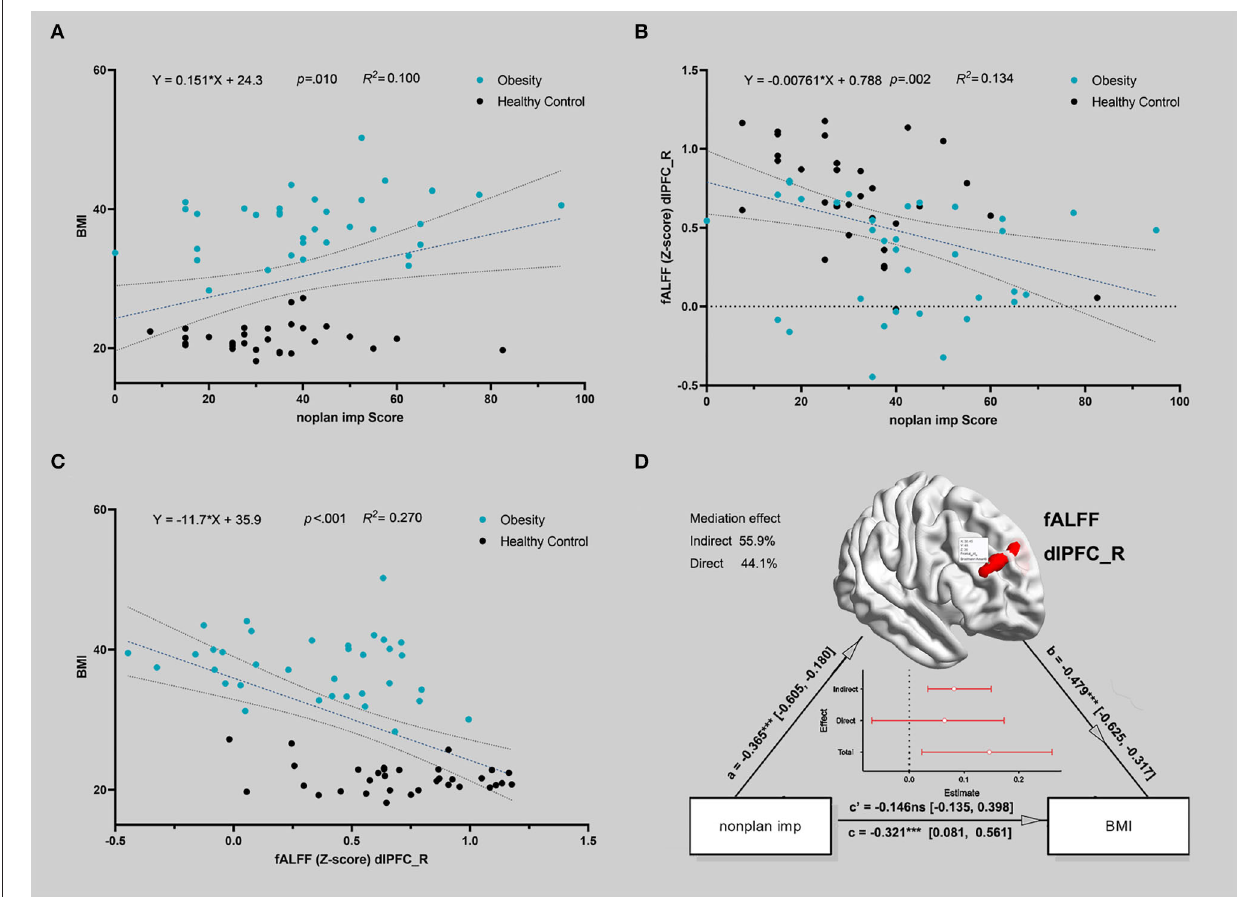
FIGURE 2 | The correlation between the activity of the brain region during delayed gratification and the severity of IGD. (A) Non-planning impulsiveness and body mass index (BMI) were positively correlated in all participants. The blue dots represent patients, and the black dots represent healthy controls. A linear fit was conducted, and the dotted line indicates the 95% confidence interval of the dotted line (in A–C ). (B) Non-planning impulsiveness and the fALFF in the right dlPFC were negatively correlated in all participants. (C) The fALFF in the right dlPFC and BMI were negatively correlated in all participants. (D) The indirect path ( via lower fALFF in the right dlPFC) completely mediated the relationship between non-planning impulsiveness and BMI for all participants. The red line in the figure represents the standardized estimation coefficient; the y-intercept indicates that spontaneous brain activity mediates the influence of impulsivity on